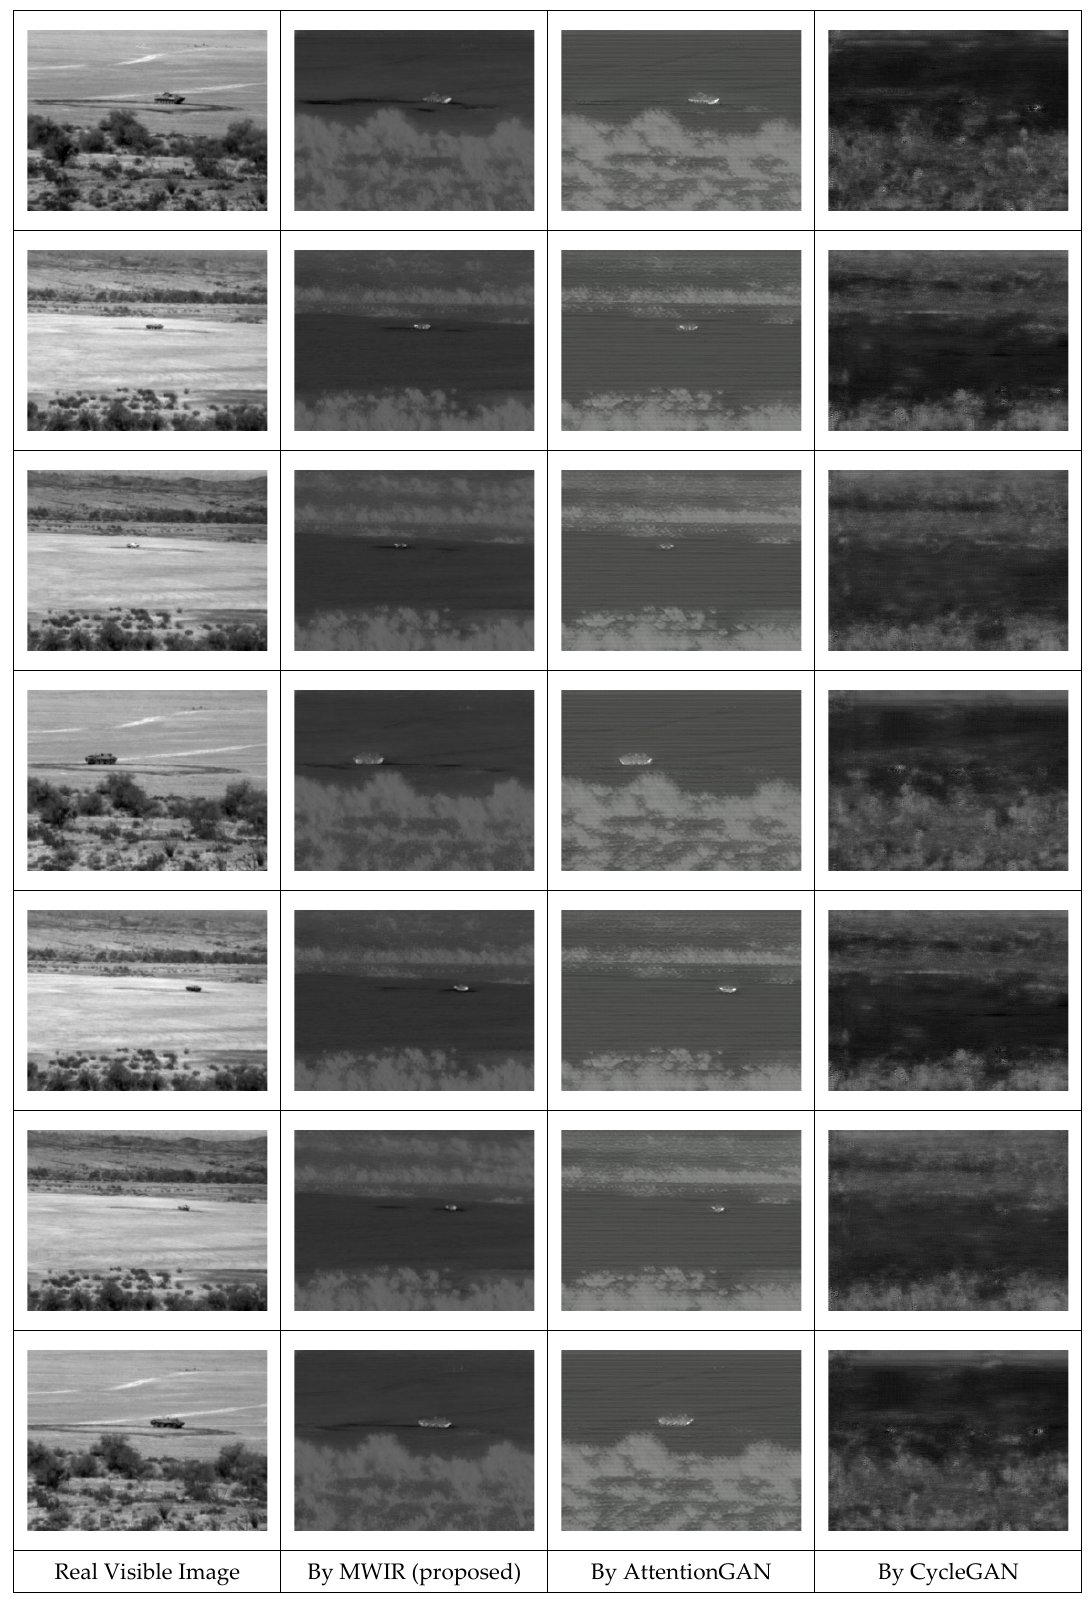
Figure 3. MWIR images generated from visible images by different models. The proposed model generated best-quality MWIR images. MWIR images generated by the AttentionGAN have visible stripe artifacts. The vehicle objects are not visible in the MWIR images generated by the